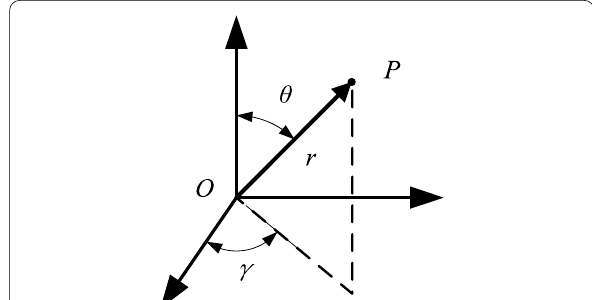
Figure 12 Setting of the spherical coordinate